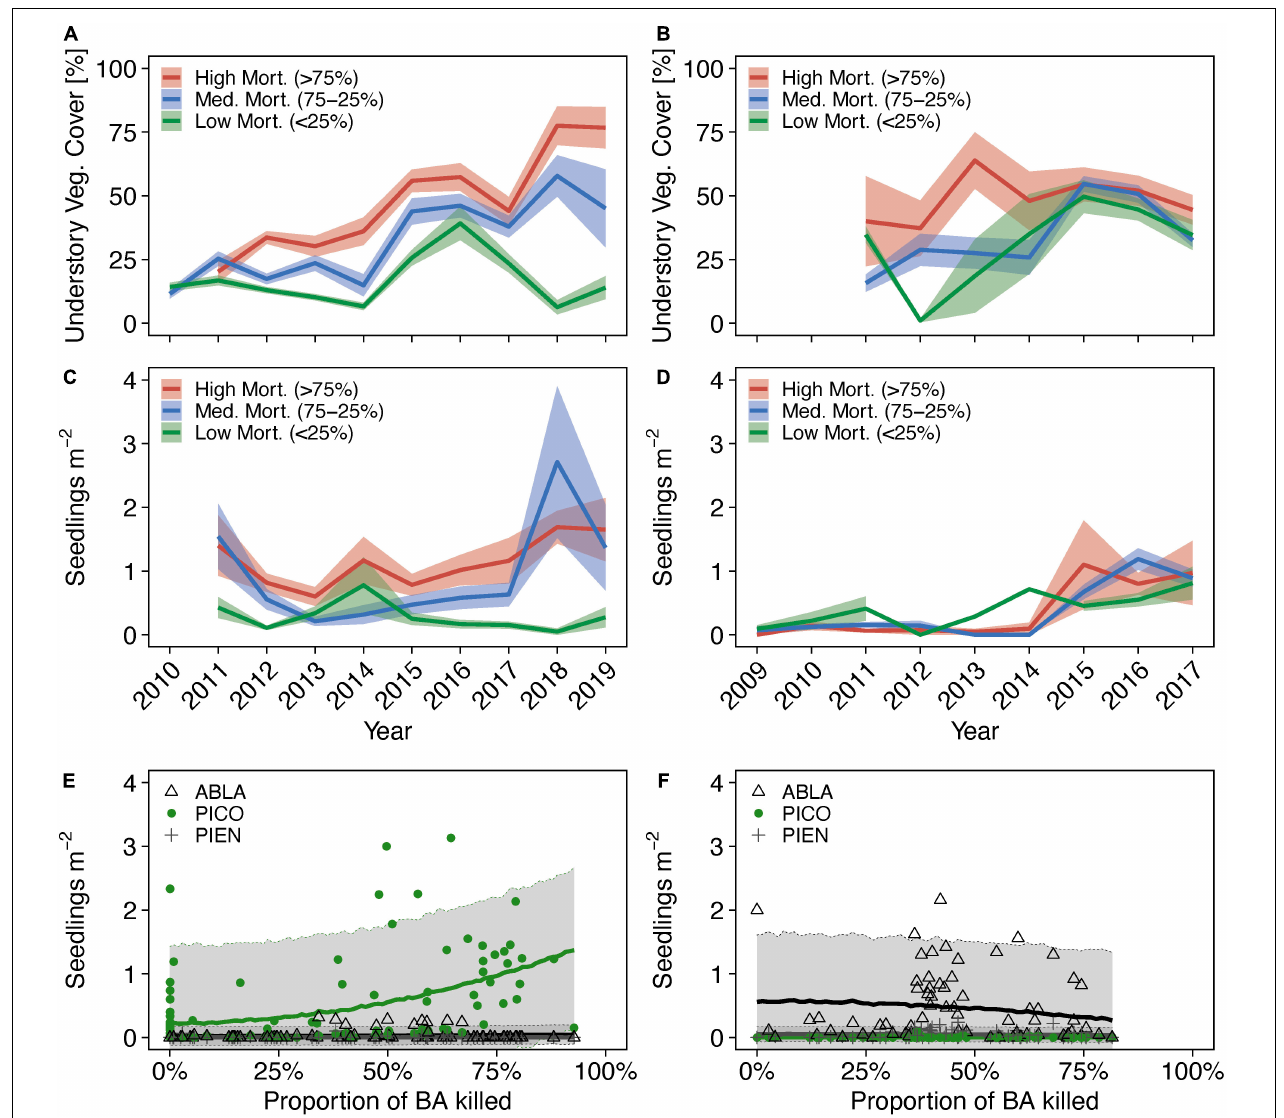
FIGURE 8 | Time series of total understory vascular plant cover (A,B) , density of total seedlings/saplings (C,D) by severity of bark beetle caused overstory mortality and density of seedlings/saplings as a function of the percentage of basal area killed by bark beetles (E,F) in lodgepole pine dominated stands (A,C,E) and in Engelmann spruce and subalpine fir dominated stands [i.e., spruce-fir stands; (B,D,F) ]. Stand dominance was based on local basal area contribution larger than 75%. Data from mixed stands are shown in Supplementary Figure 18 . Note that although understory vegetation cover data was collected in 2010 in lodgepole pine stands (A) , no plots were classified as “high mortality” in 2010, and seedling/sapling data was not collected until 2011. Understory cover was not collected until 2011 in spruce-fir stands. Lines in panels (A–D) represent mean values, bands indicate standard errors. Lines in panels (E,F) represent the means of the posterior distributions, gray bands indicate 94% credible intervals of the predicted seedling/sapling